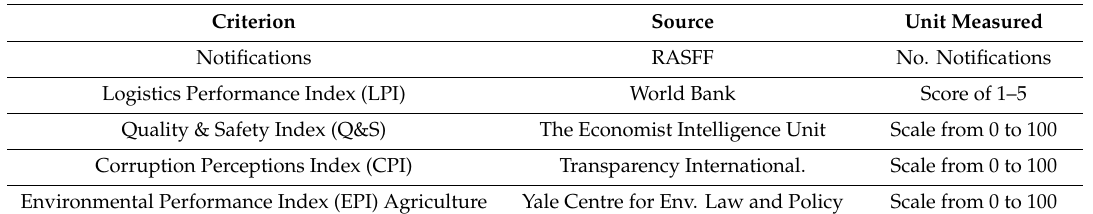
Table 4. Definitions of